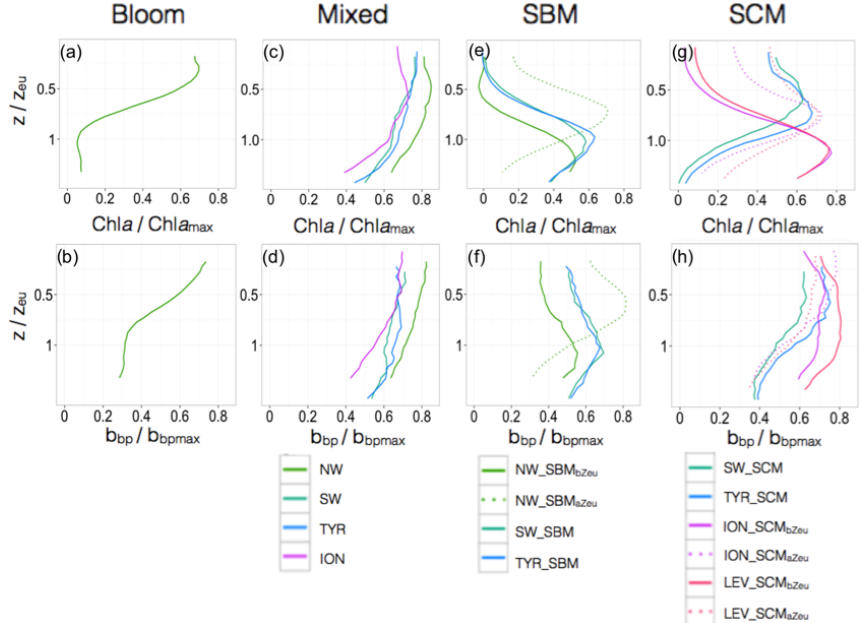
Figure 9. Normalized vertical profiles of the chlorophyll a concentration (Chl a ) (a, c, e, g) and particulate backscattering coefficient ( b bp ) (b, d, f, h) for each shape type. The Chl a and b bp are normalized to their individual profile maximum values, Chl a max and b bpmax , while the depth is normalized to the euphotic depth ( Z eu ). The colour code and the type of lines indicate the region of the Mediterranean Sea and the different shapes. The different shapes are for bloom, mixed, SBM (subsurface biomass maximum) with a distinction between the SBM aZ eu and the SBM bZ eu (for SBM occurring above or below the euphotic depth), and the SCM (subsurface chlorophyll maximum) with a distinction between the SCM aZ eu and the SCM bZ eu (for SCM occurring or below the euphotic depth). Note the different scales of the x